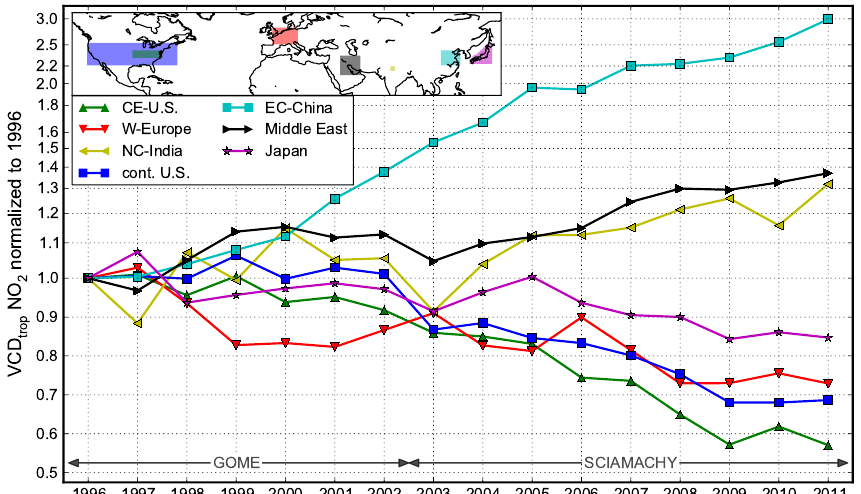
Fig. 2. Mean annual VCD trop NO 2 normalized to 1996 for the regions central East Coast US, Western Europe, US, east-central China, Japan, Middle East, and north-central India. Values for 1996–2002 are from GOME; values from 2003–2011 are from SCIAMACHY measurements. The first five regions are defined as in Richter et al. (2005). The y-axis has been modified to make relative changes above and below 1 more comparable (values larger than 1 have been scaled to y 7→ 2 − 1 / y ).